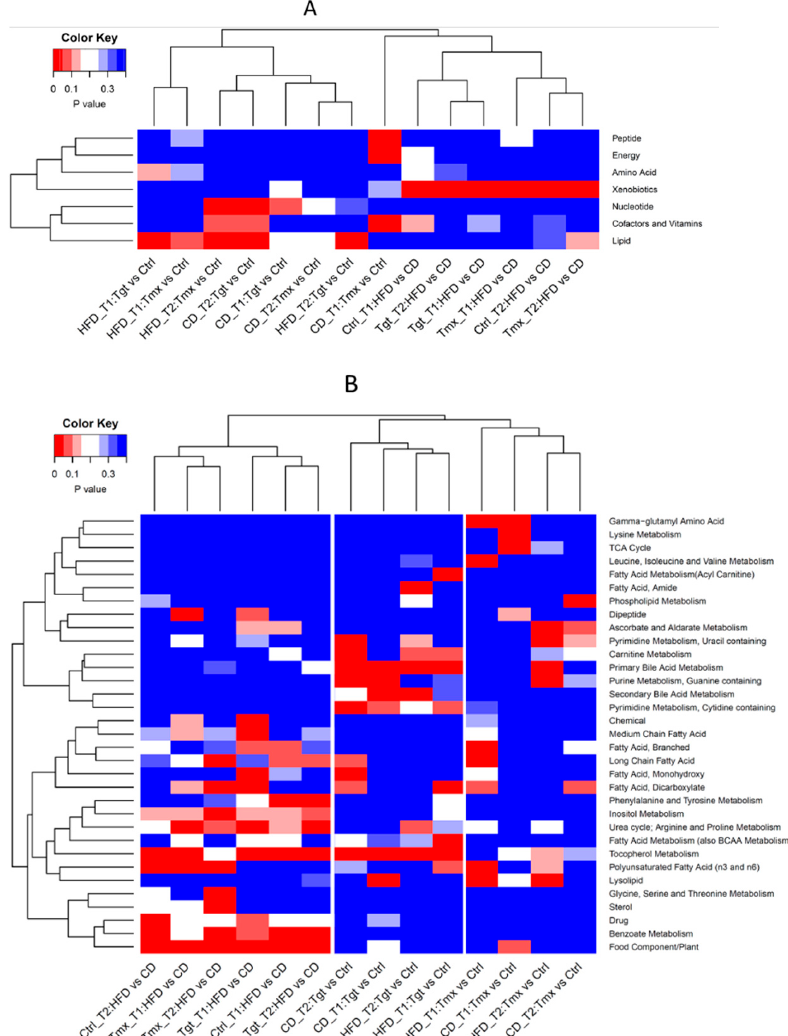
Figure 6. Hierarchical clustering analysis heatmaps of p values of pathway enrichment using Fisher’s exact test. ( A ) super pathways; ( B ) sub-pathways. Diets: standard diet (CD); high fat diet (HFD); Times: T1, 78 days of age; T2, 190 days of age; Treatments: Ctrl, control; Tgt, targretin; Tmx, tamoxifen.